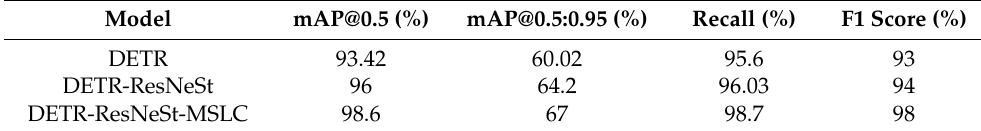
Table 3. Detection results of different models in the test set.